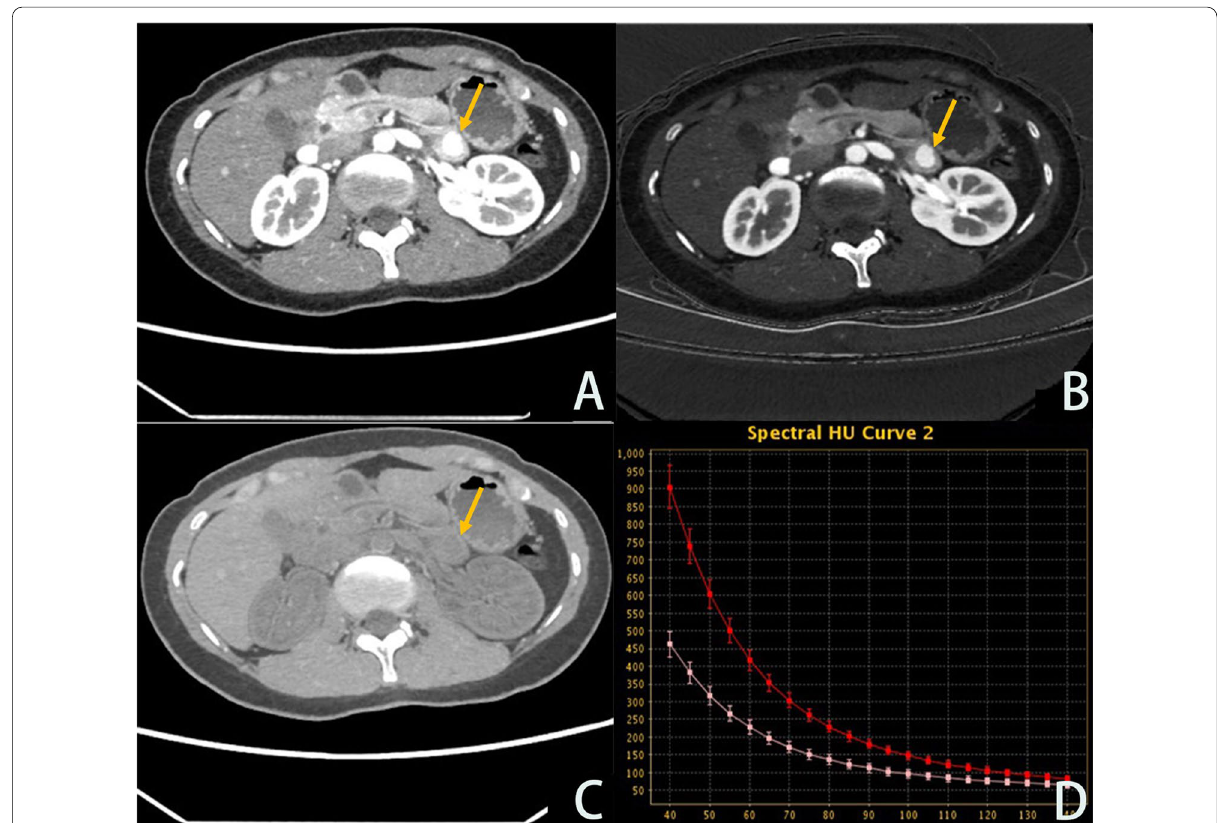
Fig. 3 Female, 30 years old, weight 60 kg, the lesion of pNET is located body and tail of pancreatic. A – C are the arterial phase energy spectrum enhancement images 70 keV images, iodine-based images, and water-based images, respectively, with the lesion enhanced to a higher degree than the adjacent parenchyma; D is the arterial phase energy spectrum curve, in which the red line is the lesion curve and the pink line is the normal parenchyma curve